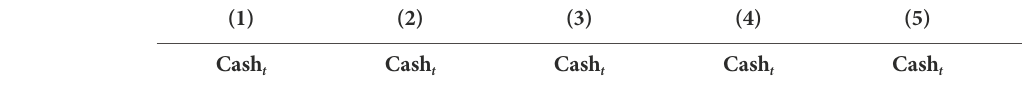
TABLE 10 Six major topics of COVID-19 and corporate cash holdings (performance review